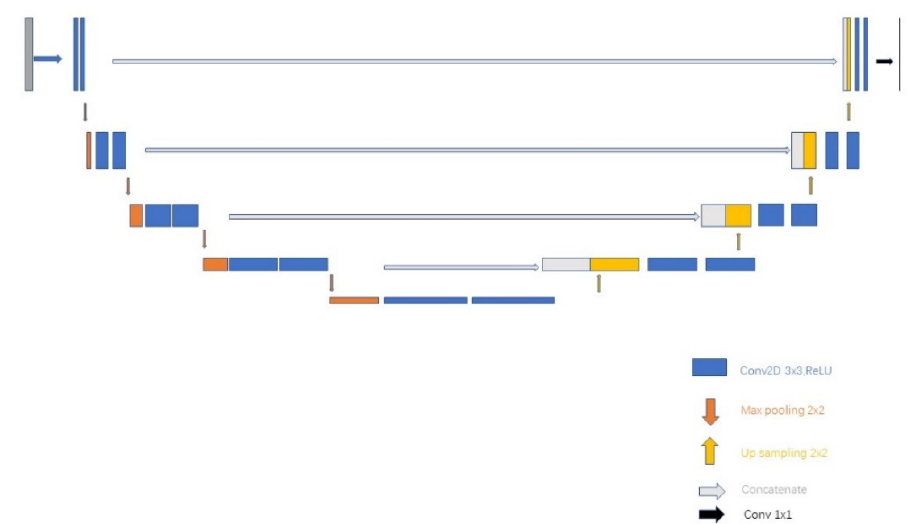
Figure 1. U-net structure. In this figure, blue represents the convolution process, and ReLU is used as the activation function. Orange represents the down-sampling process using max pooling. Yellow is the up-sampling process. The gray arrows are the jump connection structure proposed in this paper.